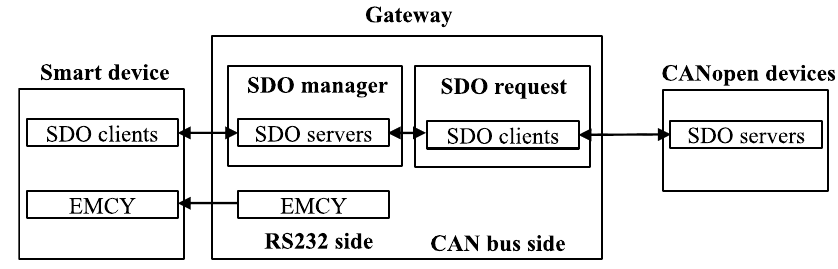
Figure 7. CANopen services of EMS.